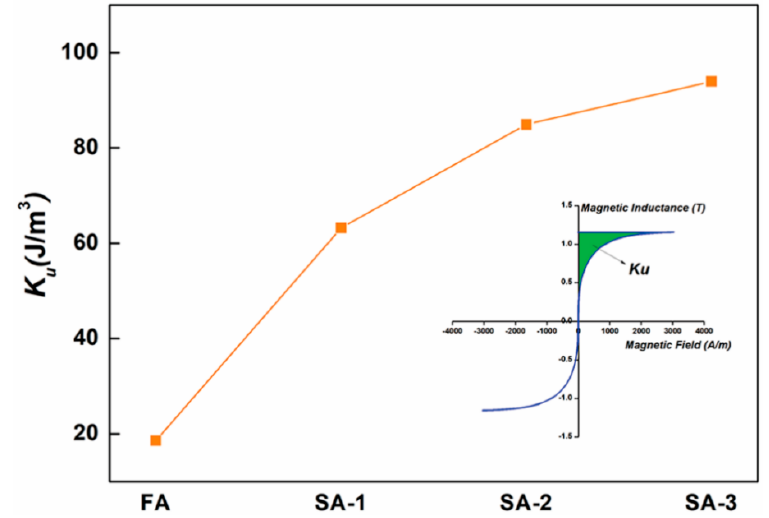
Figure 5. Magnitude of stress-induced magnetic anisotropy in treated samples. The inset illustrates the method for calculation of K u .